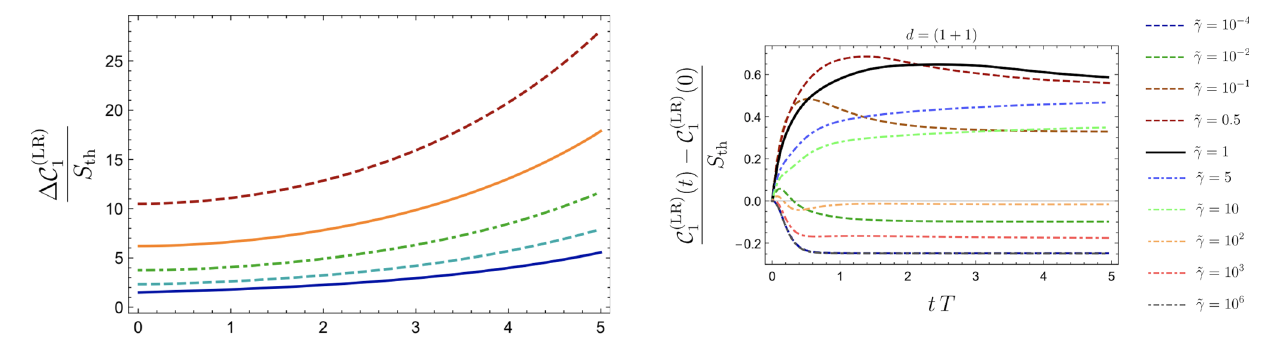
Fig. 12 Time dependence of the complexity of the thermofield double state ˜ γ ≡ (βμ) − 1 . Figure taken from [66] posed as